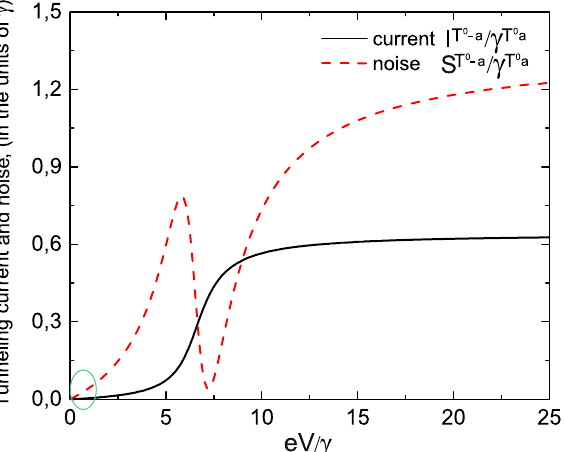
Figure 12. Tunneling current and zero frequency noise as a functions of applied bias for symmetric tunneling 1 for the T 0 a channel. Tunneling current is shown by the solid black line and contact in the limit ε/γ − ≫ zero frequency noise is depicted by the red dashed curve. Green circle shows the system parameters where Landauer–Büttiker formalism can be applied. Temperature is equal to 0.01 ε .